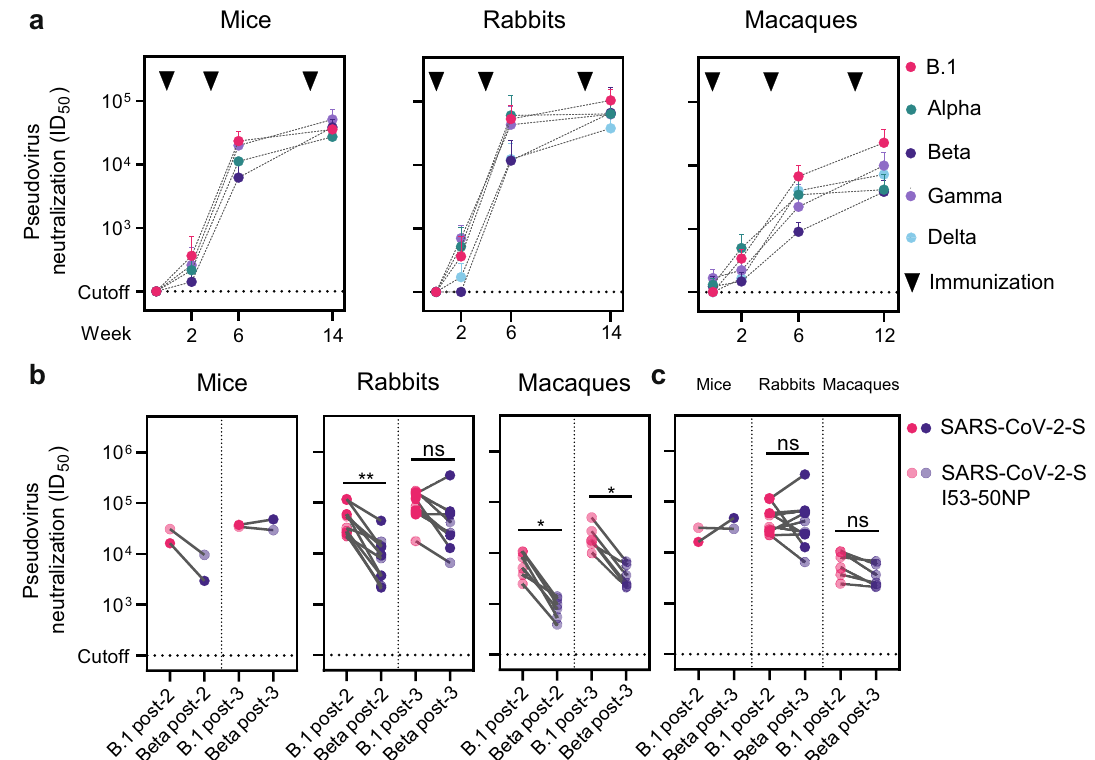
Fig. 1 Neutralizing antibody responses against SARS-CoV-2 VOC in mice, rabbits, and cynomolgus macaques after one, two, and three vaccinations with Wuhan-based Spike vaccines. a Longitudinal analysis of pseudovirus neutralization of B.1, and VOC Alpha, Beta, and Gamma in mice (left), and of B.1, Alpha, Beta, Gamma, and Delta in rabbits (middle) and macaques (right). Datapoints represent mean ID 50 ’ s, error bars indicate SD. b Paired comparisons of B.1 and Beta neutralization 2 weeks after the second and third vaccination in mice (left), rabbits (middle), and macaques (right). c Paired comparisons of Beta neutralization 2 weeks after the third vaccination and B.1. neutralization after the second vaccination in mice (left), rabbits (middle), and macaques (right). Mice and rabbits groups immunized with SARS-CoV-2 S-I53-50NP and SARS-CoV-2 S were combined for the analyses because the responses were overall quite comparable, but the individual data are given in Supplementary Tables 1 and 2. Mouse sera were pooled per group because of low serum amounts. The neutralization titers between variants were compared using the Wilcoxon test (* P < 0.05; ** P <